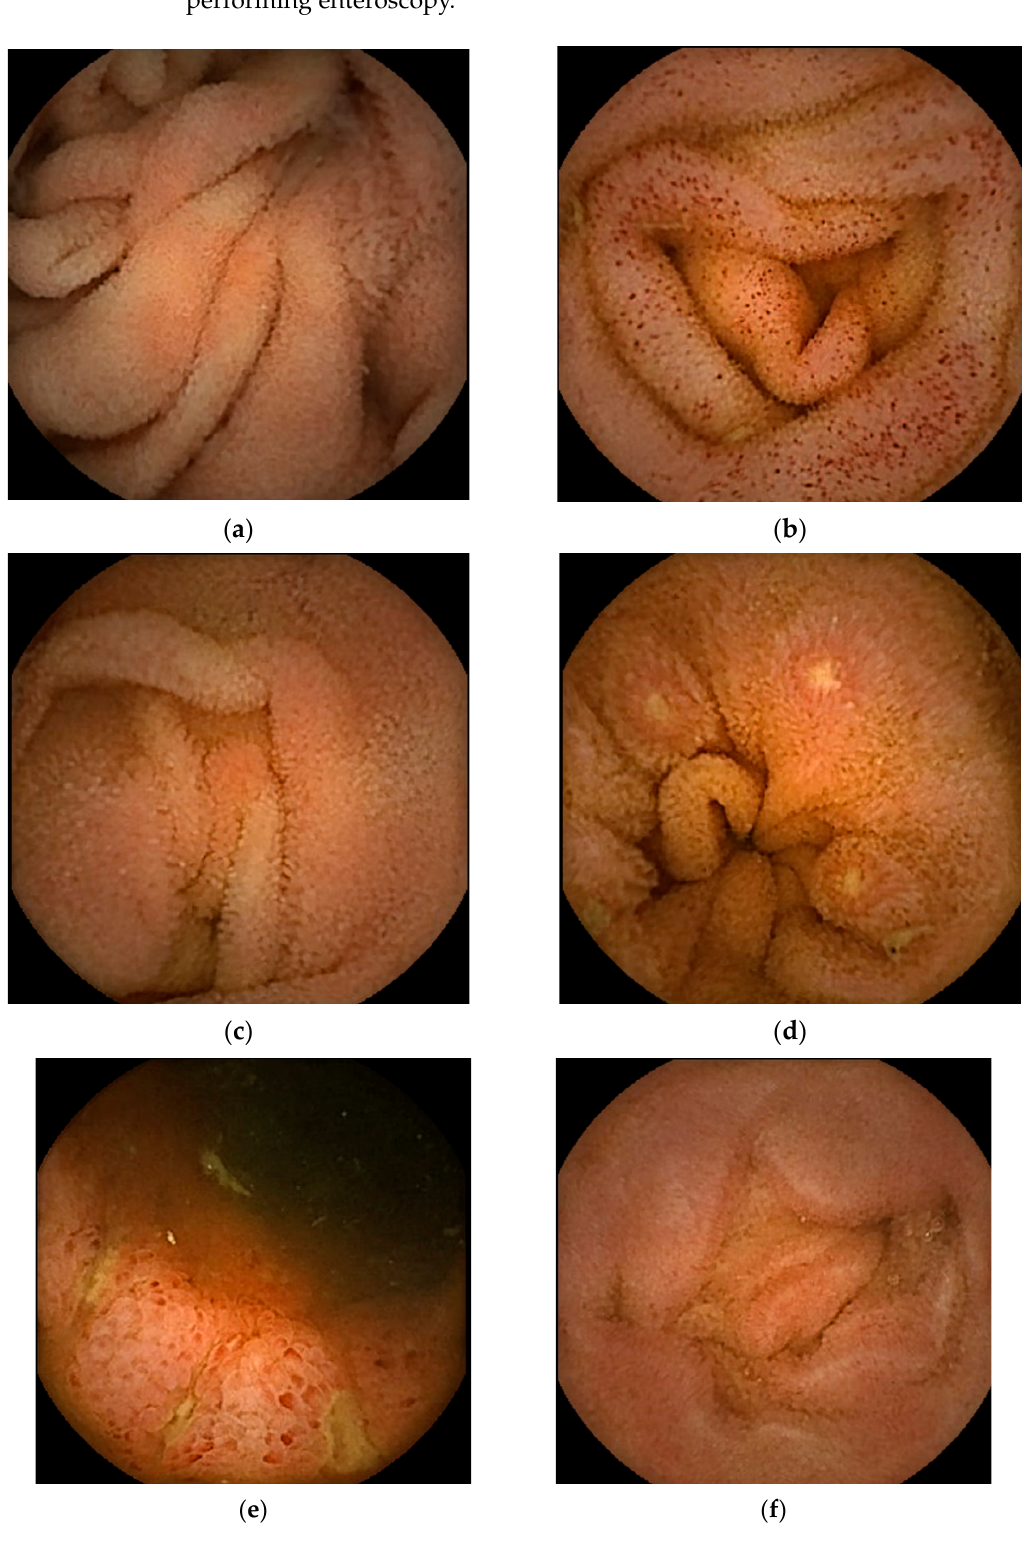
Figure 2. Representative images of small bowel capsule endoscopy of our own EoGE cases: ( a ) patchy redness with edema and atrophy; ( b ) scattered redness with edema; ( c ) villous atrophy with redness; ( d ) erosions with surrounding redness; ( e ) ulcers; ( f ) edema. All images were captured with PillCamSB3 (Covidien Japan Inc., Tokyo, Japan). EoGE: eosinophilic gastroenteritis. We found only one original study [26] that examined small bowel endoscopic find- ings of EoGE. This retrospective study included 123 patients with EoGE. The duodenal findings reported were friability (2%), erythema (2%), nodularity (3%), stricture (1%), and ulcer (6%). However, in all patients, findings in the jejunum and ileum were not endo- scopically evaluated. This paper concludes that mucosal findings are normal in many cases of EoGE, and that tissue biopsy is important for diagnosis and determining treat- ment efficacy. 4. Biopsy Methods In the 13 cases [11–23] and two case series [24,25] reviewed here, eosinophilic infil- tration of the small intestinal mucosa was basically detected using target biopsy tissue from endoscopically detected lesions (Table 1). In one case [15], a random biopsy from a normal-looking mucosa demonstrated eosinophilic infiltration, while in another case [14], a similar biopsy failed to detect eosinophilic infiltration originating from an area where no findings were identified. It is important to accurately identify subtle findings such as erosions and actively perform biopsies to diagnose EoGE [24]. Endoscopic findings are not always associated with eosinophilic infiltration in the mucosa [25]. In a recent analysis of patients with moderate-to-severe gastrointestinal symptoms participating in a clinical trial of lirentelimab for EoG and/or eosinophilic duodenitis (EoD) [28], a high percentage of patients with EoG/EoD were detected by systematic endoscopic biopsy [29]. In this study, EoG diagnosis required presence of ≥ 30 eosinophils/high-power field (eos/hpf) in ≥ 5 hpfs and EoD required ≥ 30 eos/hpf in ≥ 3 hpfs. Eosinophils were patchy in gastric and duodenal biopsies and counting eosinophils in at least 8 gastric biopsies and 4 duodenal biopsies was required to identify a patient with EoG/EoD [29]. When systematic biopsy histology is performed for the diagnosis of patients with chronic gastrointestinal symp- toms, it is important to differentiate EGIDs from functional gastrointestinal disorders such as functional dyspepsia and irritable bowel syndrome It is also critical to appropriately communicate with the pathologist and request for evaluation of eosinophilic infiltration. 5. Complication Related to Enteroscopic Evaluation for EoGE Diagnosis All four patients with circumferential ulceration developed stenosis [12,19,20,22], three of which resulted in capsule endoscopy retention [12,19,22]. One of the three cases required partial resection of the ileum for capsule endoscopy retrieval [22]. In the other two cases, the capsule was fortunately eliminated after treatment with oral budesonide